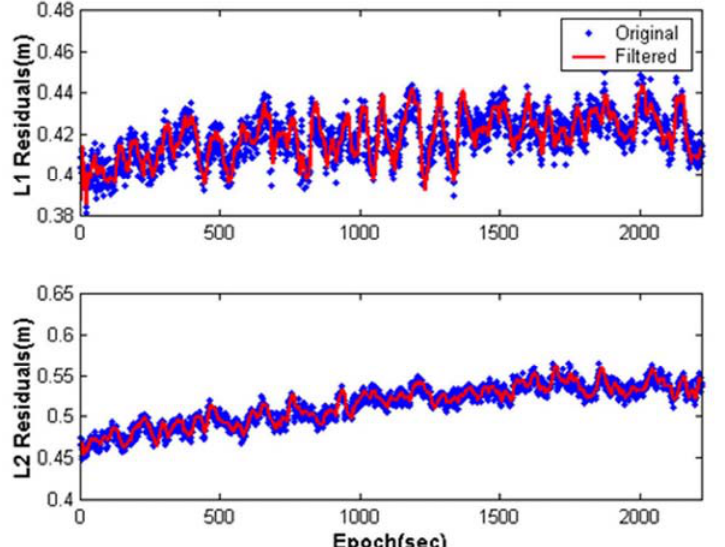
Figure 7 shows the interpolated satellite-by-satellite and epoch-by-epoch L1 and